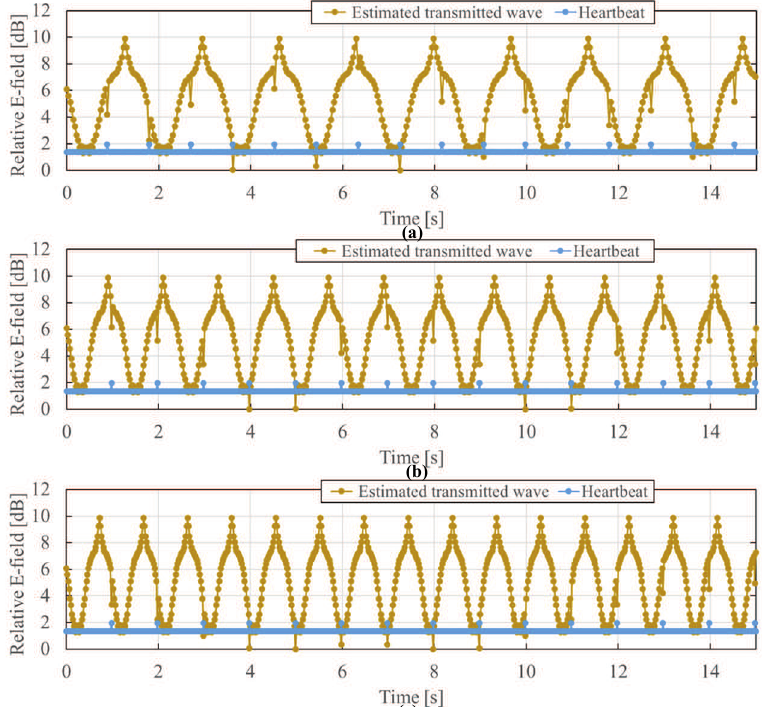
Figure 8. Time waveform of extracted transmitted electric field at Sensor C. The yellow line is the transmitted electric field, and the blue line is the assumed heartbeat timing. The peak generated by the diastole and systole of the heart is 1 dB or more at the assumed heartbeat position. The other positive and negative peaks correspond to the positions where the body movement direction switches from left to right or from right to left. Body movement frequency: ( a ) 0.6 Hz, ( b ) 0.8 Hz, ( c ) 1.0